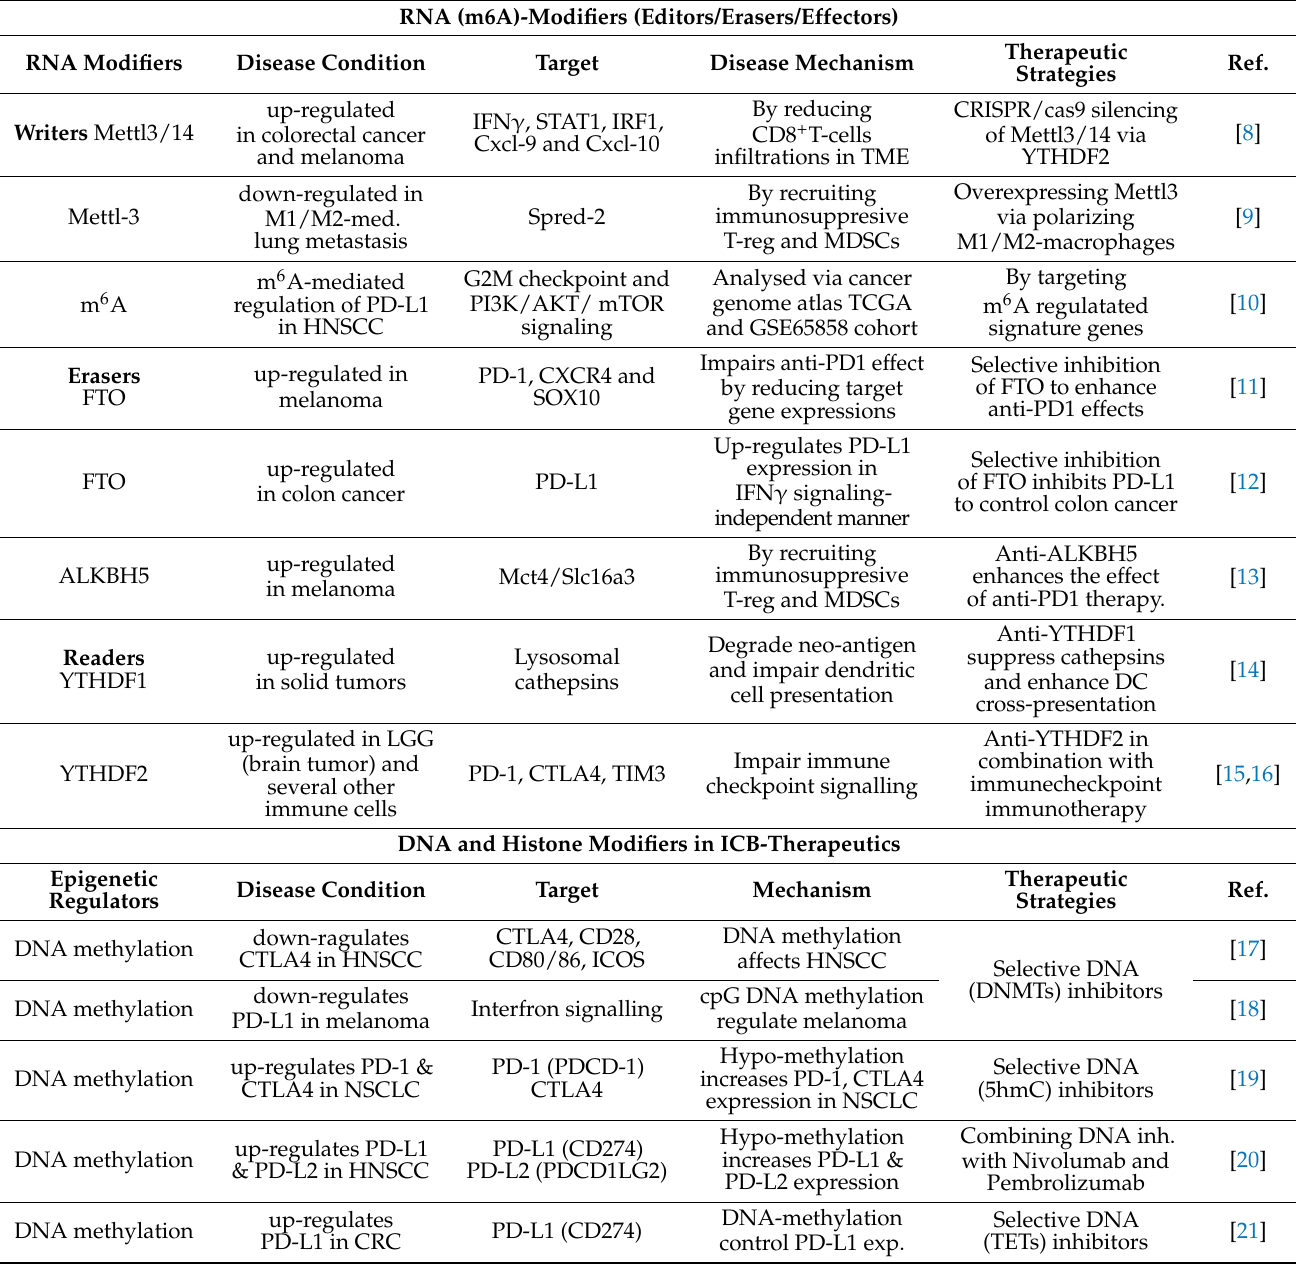
Table 1. Epigenetic modifiers and microRNAs in improving the efficacy of ICB-therapy. RNA (m6A)-Modifiers